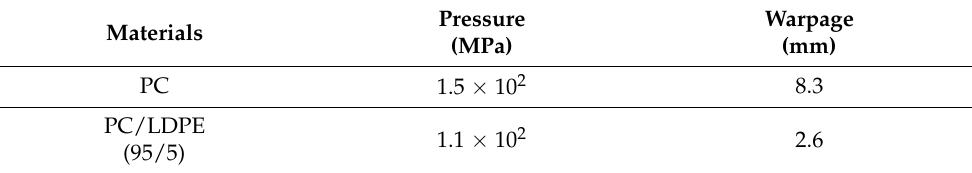
Table 2. Injection pressures and warpage values.